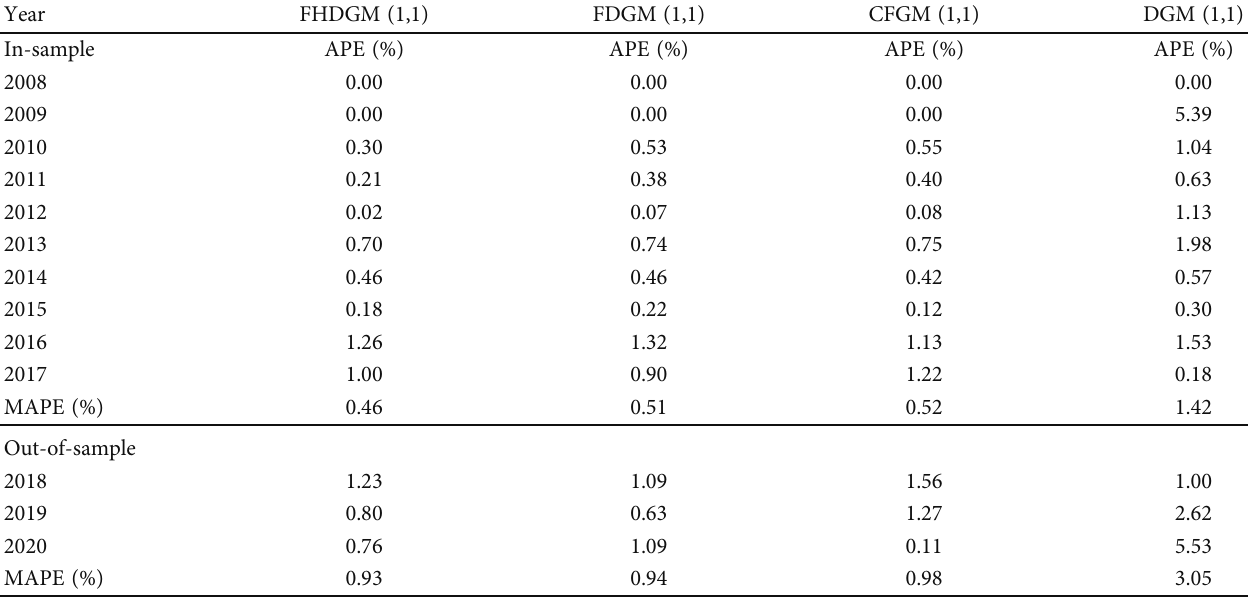
Table 16: The values of APE and MAPE are generated by the four